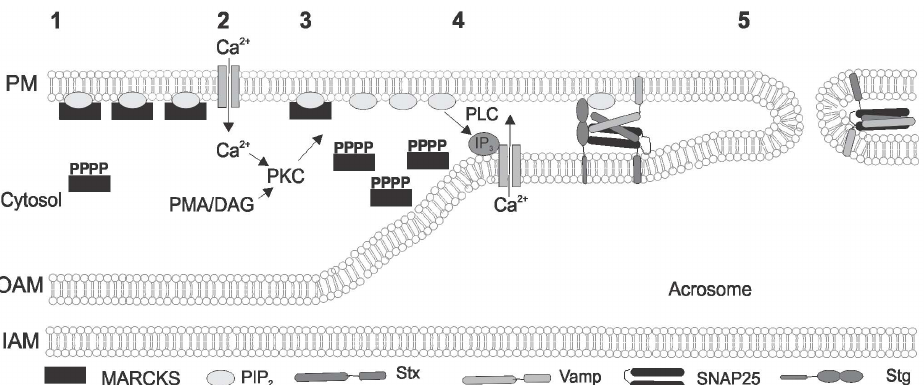
Figure 6. Working model for the role of MARCKS in acrosomal exocytosis. In resting sperm, MARCKS is present in two forms, a phosphorylated form in cytosol and another non-phosphorylated form, which binds to membranes sequestering PIP 2 (1). When sperm is activated by a natural inducer such as progesterone, acrosomal exocytosis is triggered by a cytoplasmic increase of Ca 2 + (2). Then, Ca 2 + and DAG activate conventional PKC. Activated PKC phosphorylates the effector domain of MARCKS. Phosphorylated MARCKS is translocated to cytosol, augmenting the availability of PIP 2 (3). PIP 2 is hydrolyzed by PLC to generate IP 3 and DAG. IP 3 elicits the efflux of Ca 2 + from acrosome (4). In addition, PIP 2 interacts with SNAREs proteins and synaptotagmin (Stg) to fuse plasma and outer acrosomal membranes (5). Stx, syntaxin; VAMP, vesicle associated membrane protein; SNAP-25, synaptosomal-associated protein 25.